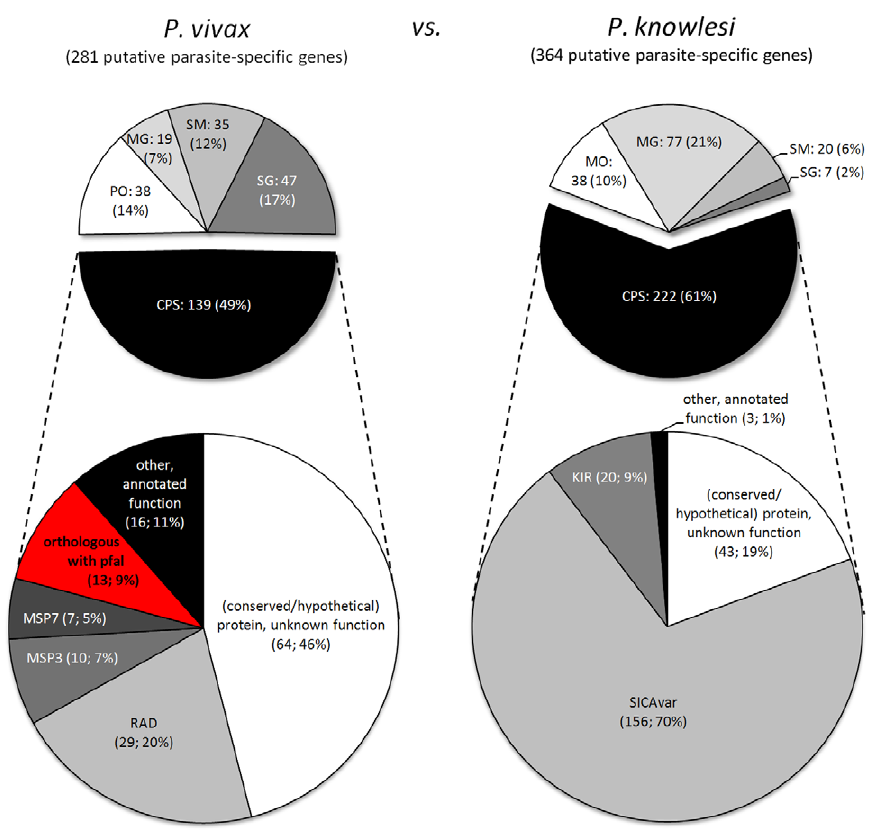
Figure 7. Human parasites P.falciparum and P.vivax share 13 syntenic orthologs that are absent in the monkey parasite P.knowlesi . Putative chromosome-internal parasite-specific genes between the human parasite P. vivax (281 genes) and the closely related macaque monkey parasite P. knowlesi (364 genes) were examined within their syntenic context. Slices in white and shades of gray in the upper two diagrams show excluded questionable parasite-specific genes, including differences due to positional orthologs (PO), potential missing genes (MG), sequence gaps (SG), and potential split/merged genes (SM). Black slices represent confirmed parasite-specific (CPS) genes examined for their function. Of the 139 confirmed P. vivax -specific genes, 13 genes (9%, shown in red and in Table 2) have a syntenic ortholog in P. falciparum and thus represent genes present in both human parasites but absent in P. knowlesi .